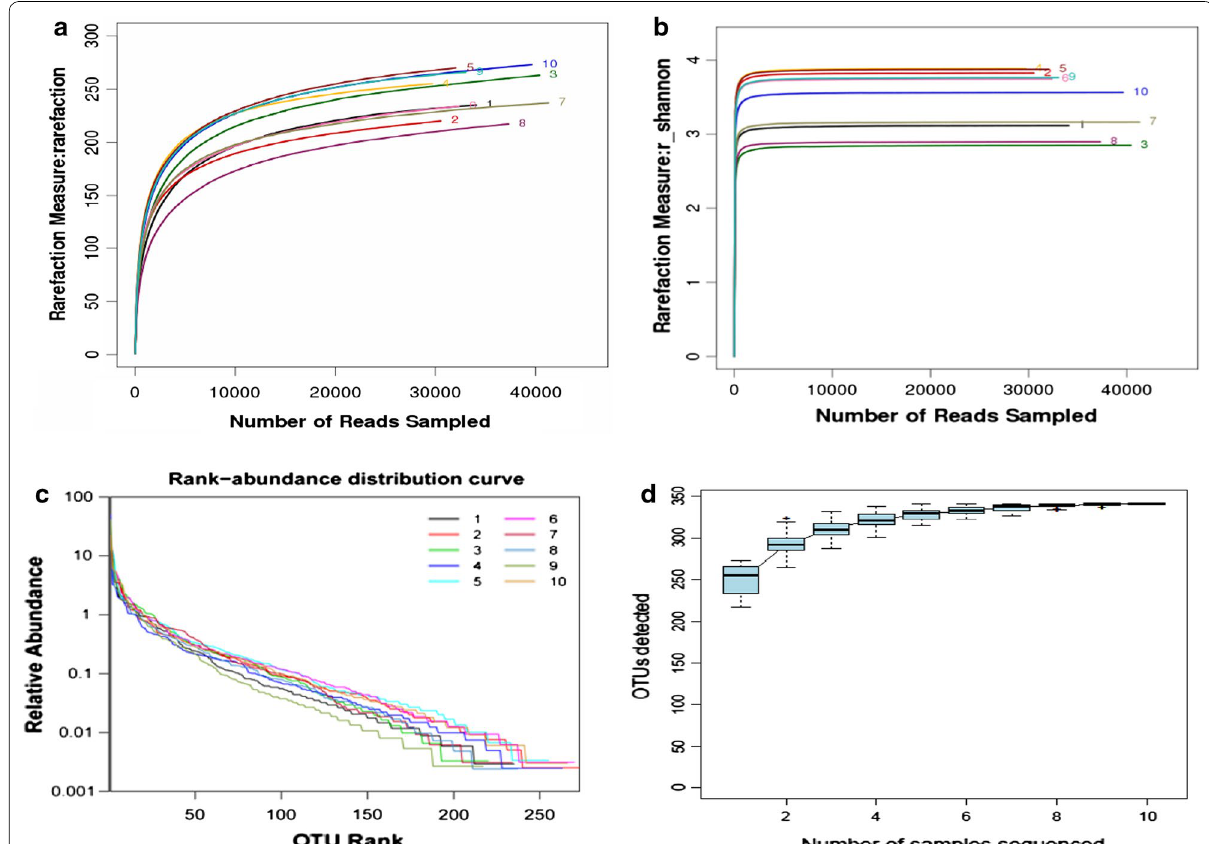
Fig. 2 Results of the rarefaction, Shannon, Specaccum accumulation and relative abundance analysis. a The rarefaction curve, b Shannon curve, c Specaccum accumulation curve, and d relative abundance